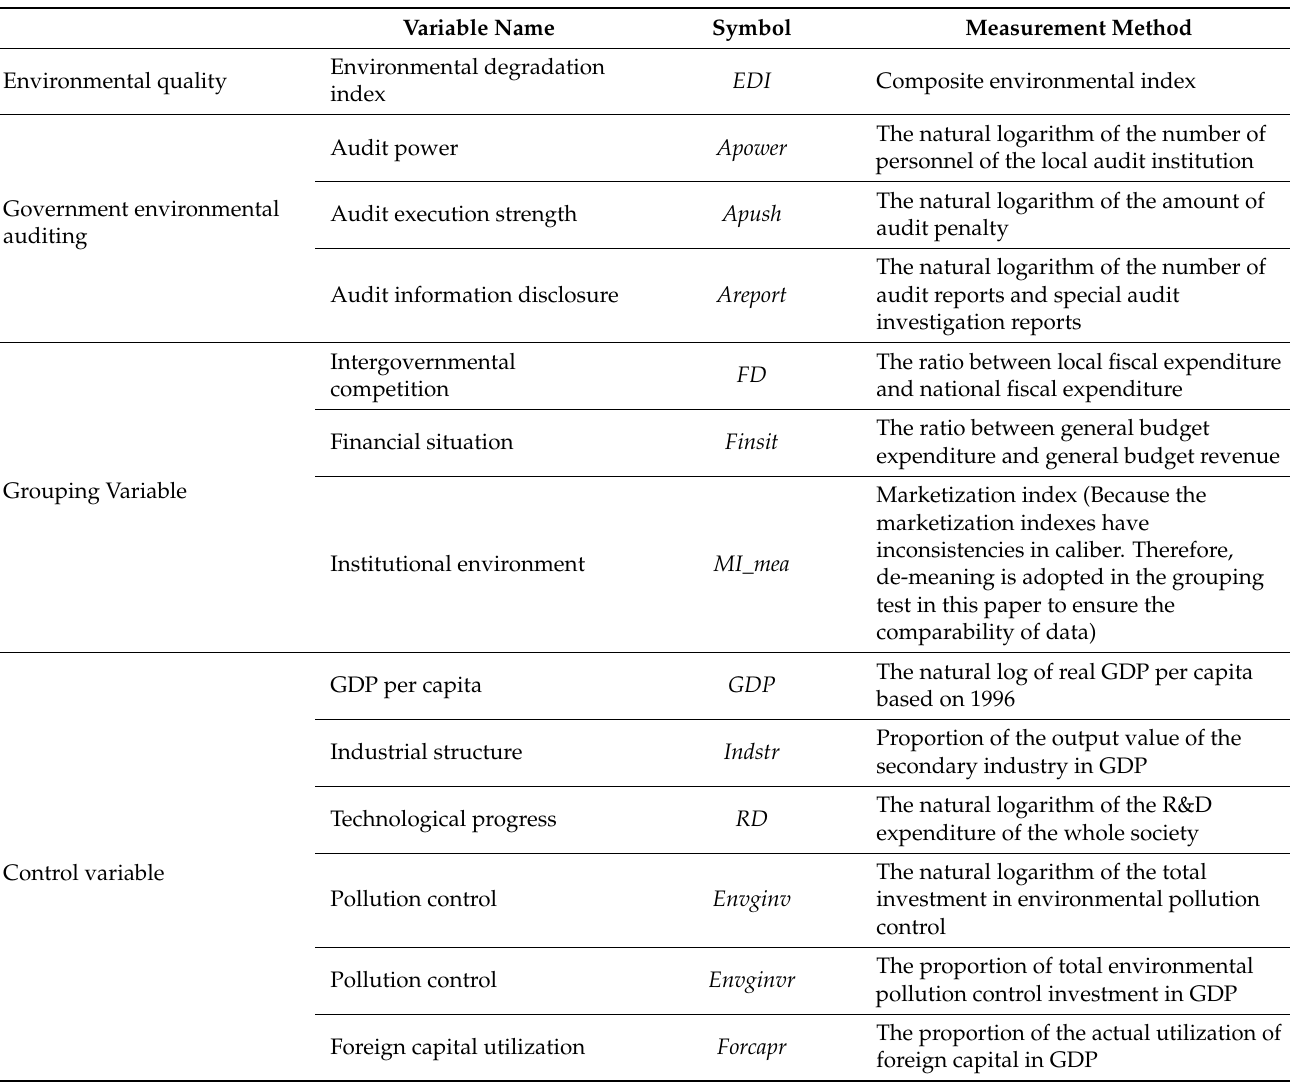
Table 1. Definitions of